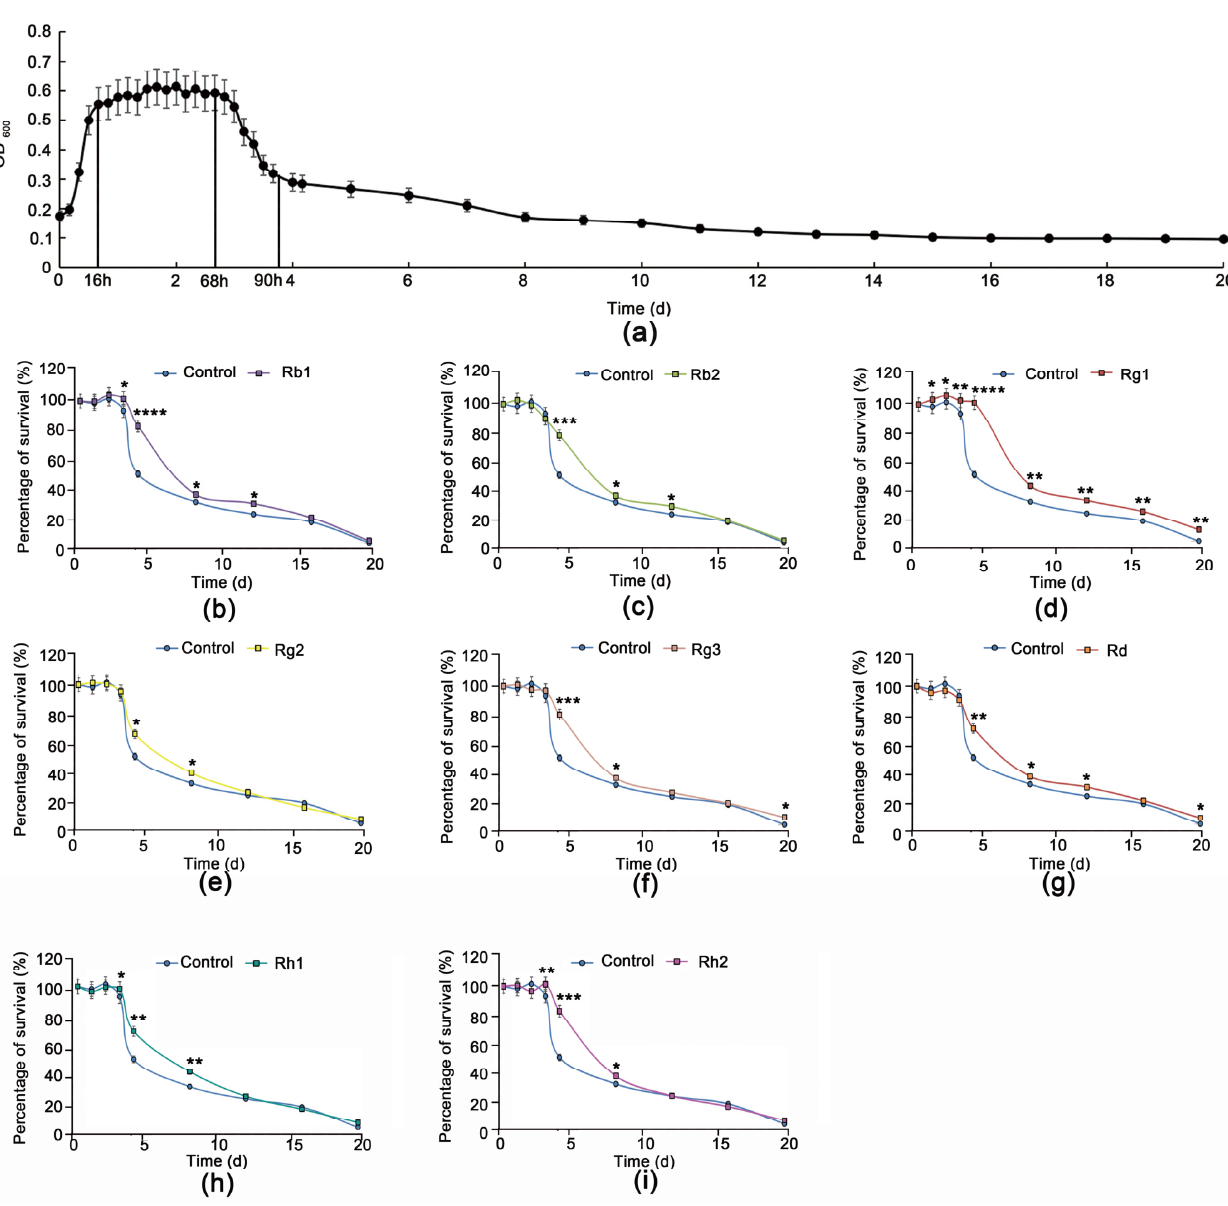
Figure 1. Ginsenosides promote survival of Saccharomyces cerevisiae cells. Growth curves of yeast cells without treatment ( a ). Survival percentage curve on treatment with ginsenoside monomers Rb1 ( b ), Rb2 ( c ), Rg1 ( d ), Rg2 ( e ), Rg3 ( f ), Rd ( g ), Rh1 ( h ), and Rh2 ( i ) (all at 180 μg/mL). Data are expressed as the mean ± SD; n = 3. Compared with untreated controls, * p < 0.05, ** p < 0.01, *** p < 0.001, **** p < 0.0001.